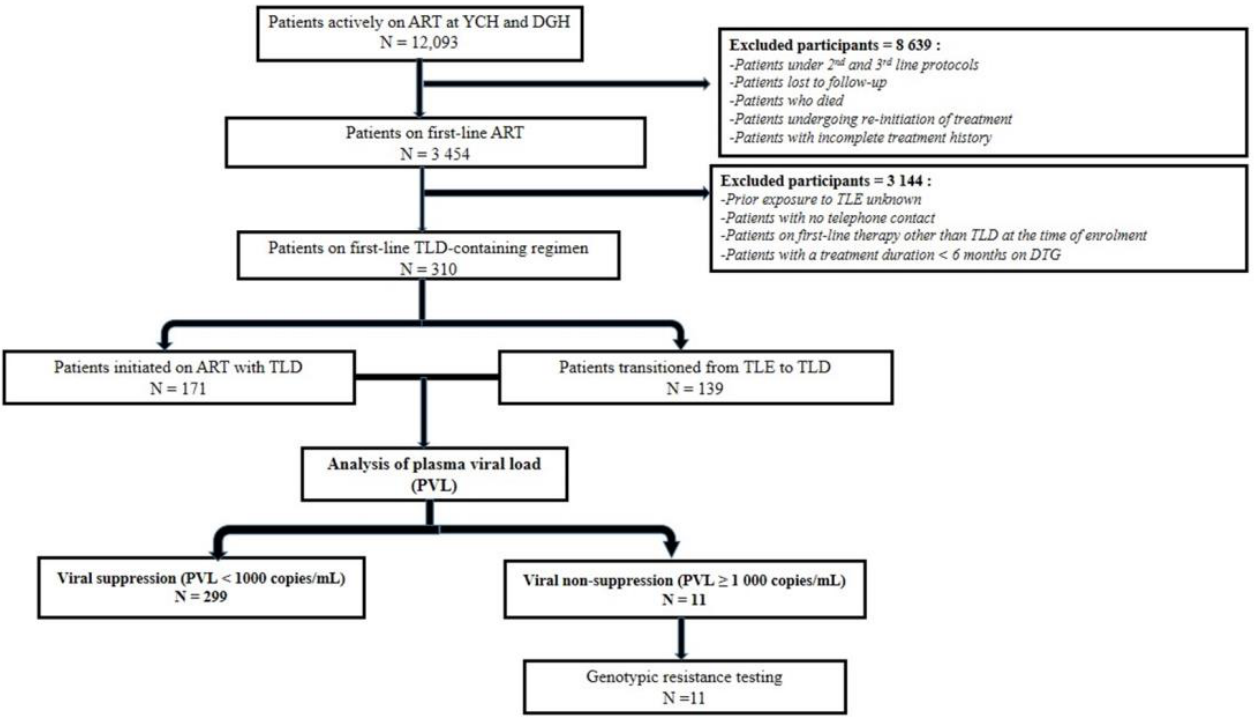
Figure 1. Flow chart of patients’ enrolment and follow-up in the study population. Legend. Bold represents subtitles.